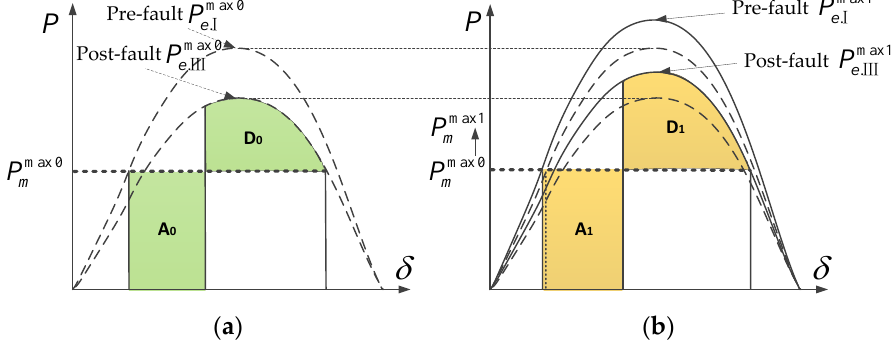
Figure 5. ( a ) Diagram of power-angle curves when X Σ = X Σ 0 . ( b ) Diagram of power-angle curves when X Σ = X Σ 1 .